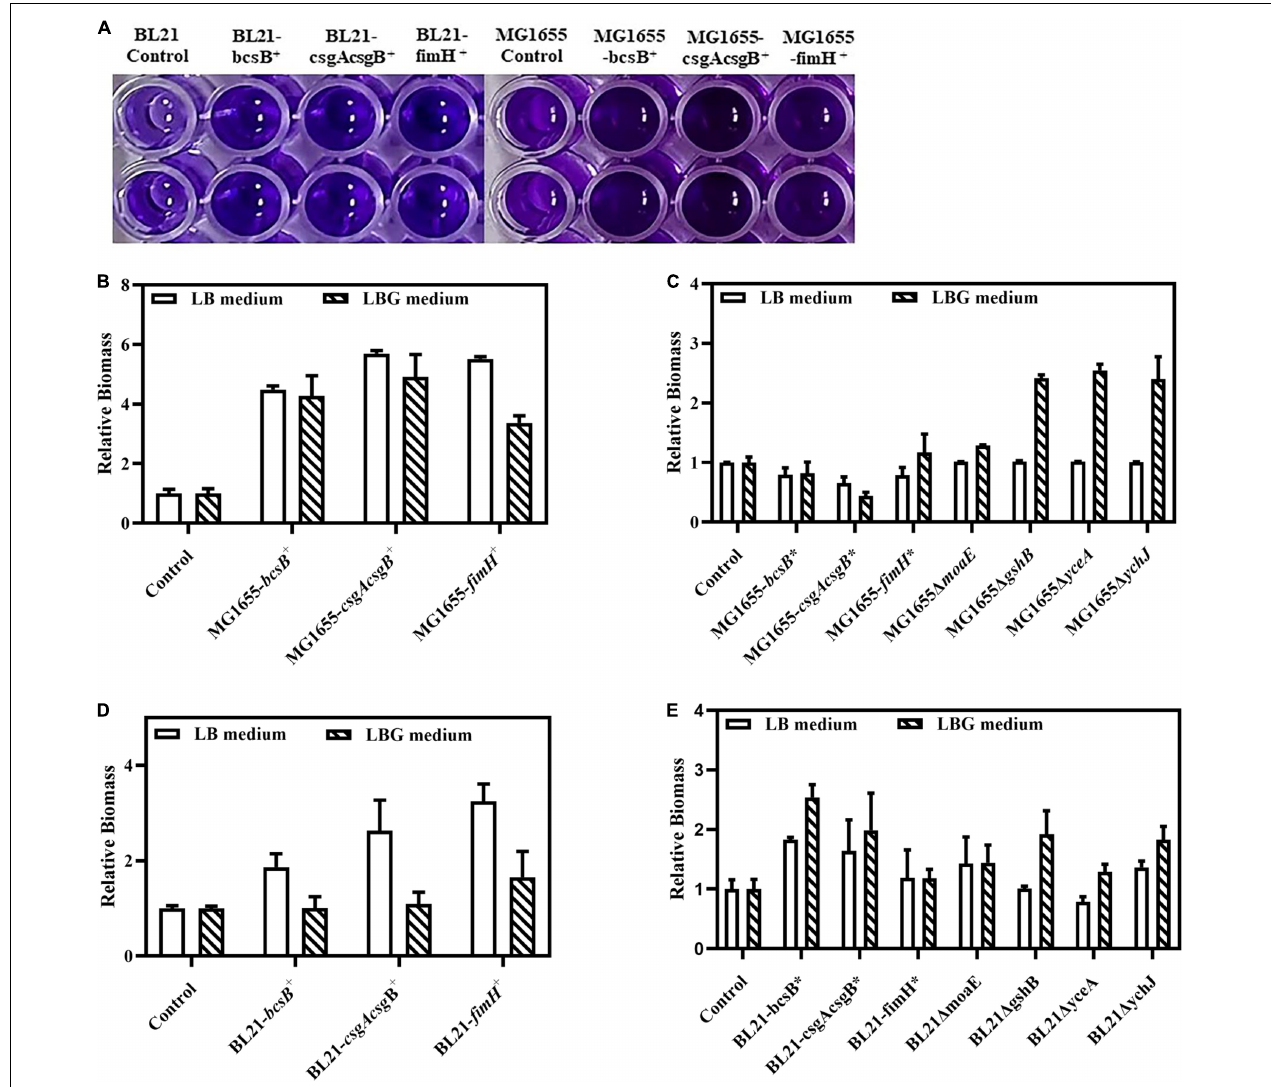
FIGURE 2 | Crystal violet staining based quantification of biofilm biomass. (A) Crystal violet staining of biofilm in 96-well plates. (B) Relative biofilm biomass of MG1655 strains with plasmid-based overexpression of biofilm related genes. (C) Relative biofilm biomass of MG1655 strains with genome-integrated expression of or disruption of biofilm related genes. (D) Relative biofilm biomass of BL21 strains with plasmid-based overexpression of biofilm related genes. (E) Relative biofilm biomass of BL21 strains with genome-integrated expression of or disruption of biofilm related genes. The biofilm amounts of control strains were set as 1.0 and those of the corresponding recombinant strains were expressed as fold